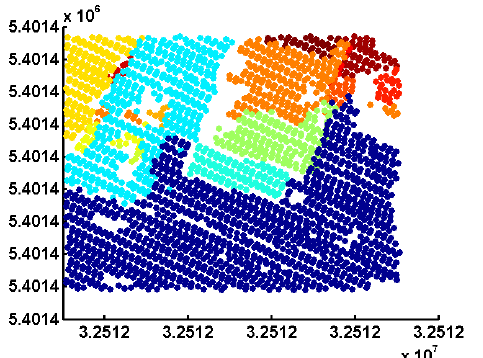
Figure 3. The point cloud is profiled in different